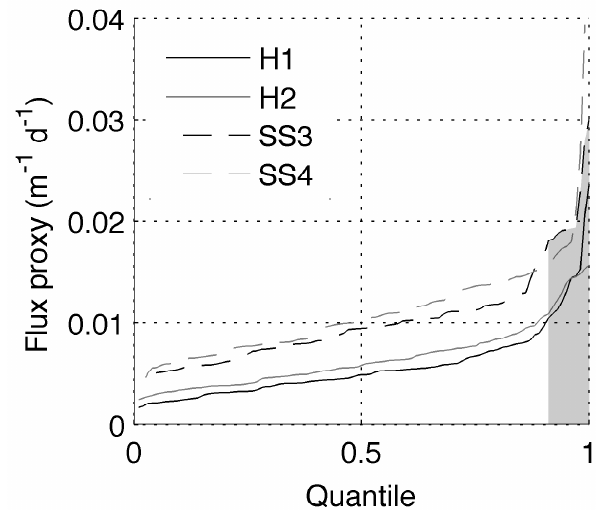
Fig. 6. Cumulative distribution plot of 1day, bin-averaged, contin- uous flux proxy data from floats H1–SS4. Solid lines show Pacific floats, and dashed lines Atlantic floats. Gray-shaded area illustrates the contribution of the top 10% (90th–100th percentile range) of 1-day flux averages observed by float